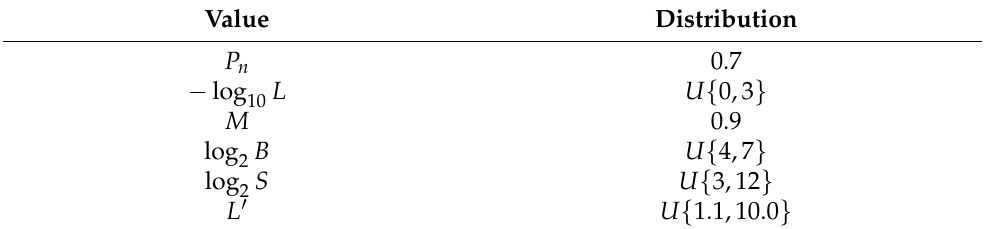
Table 2. Distributions for a random hyperparameter search.